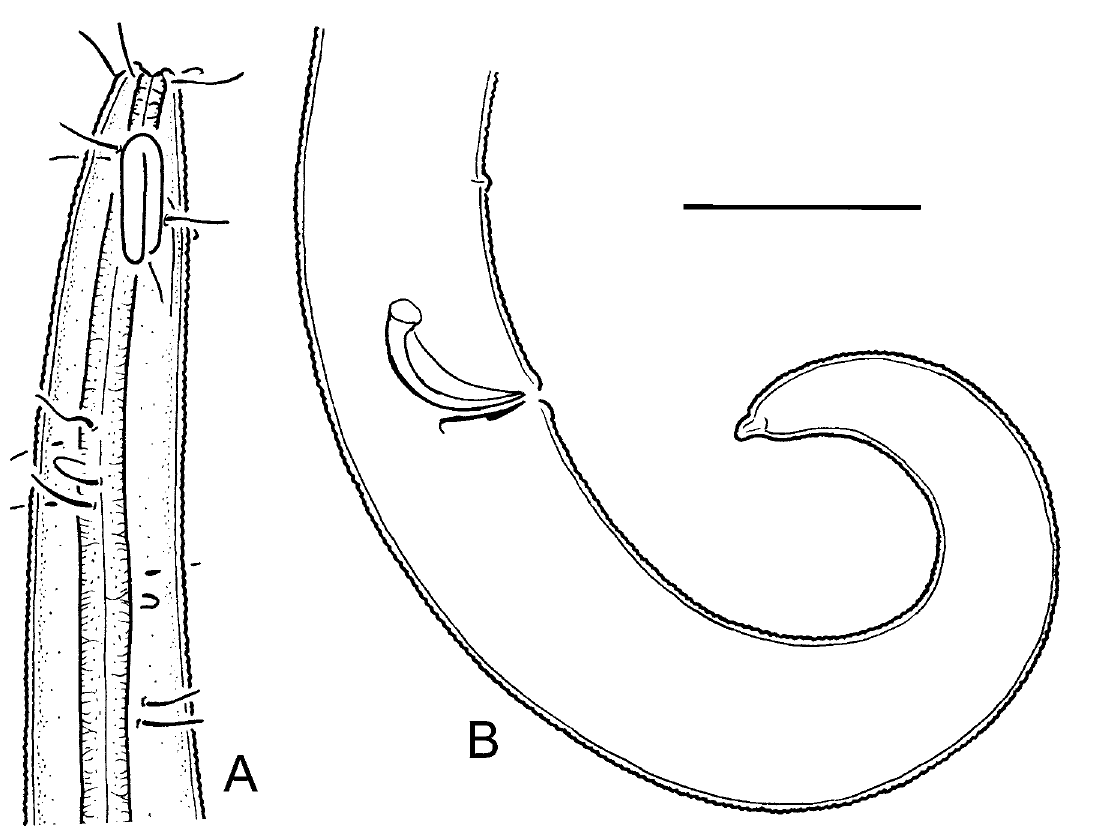
Fig. 4. Pseudaraeolaimus cylindricauda (Allgén, 1932) comb. nov. lectotype male (SMNH Type-3435). A . Anterior end. B . Posterior end. Scale bar = 20